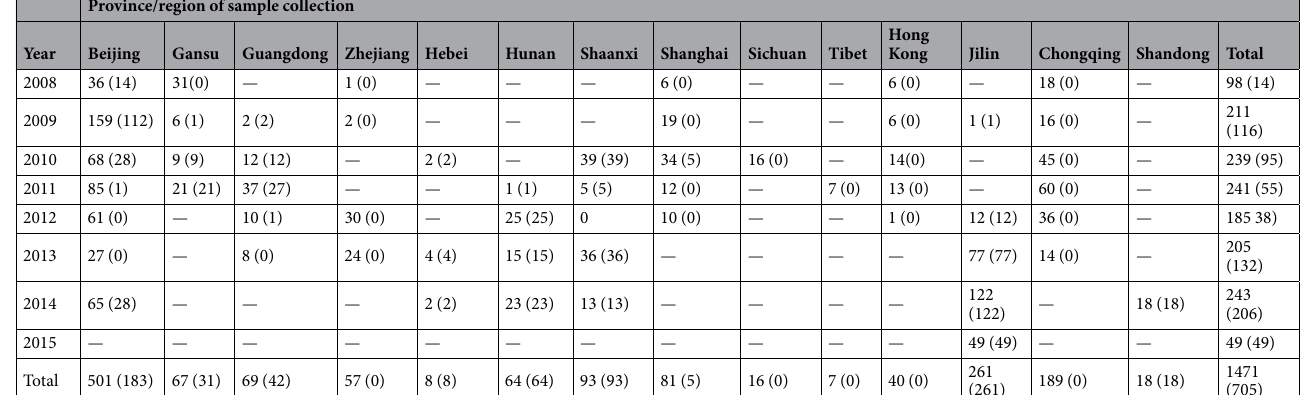
Table 1. Distribution of HRSV samples collected in China from 2008 to 2015 by year and geographical region. Numbers shown are the sum of sequences collected in this study and those downloaded from GenBank; sequences collected in this study are shown within